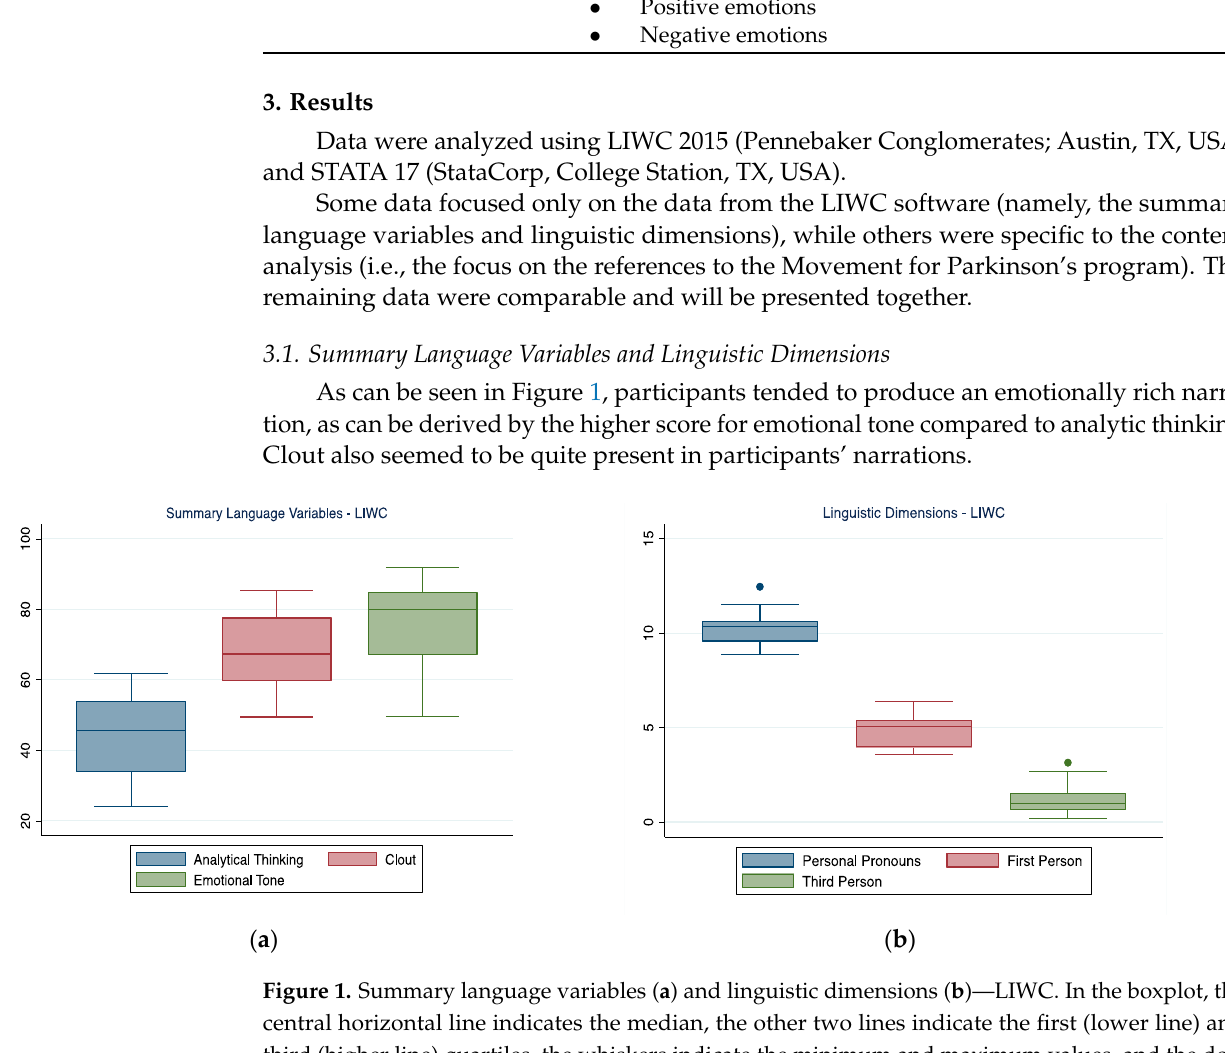
( b ) Figure 2. Emotions expressed in the interviews as reflected by LIWC ( a ) and CA ( b ). In the boxplot, the central horizontal line indicates the median, the other two lines indicate the first (lower line) and third (higher line) quartiles, the whiskers indicate the minimum and maximum values, and the dots indicate outliers.